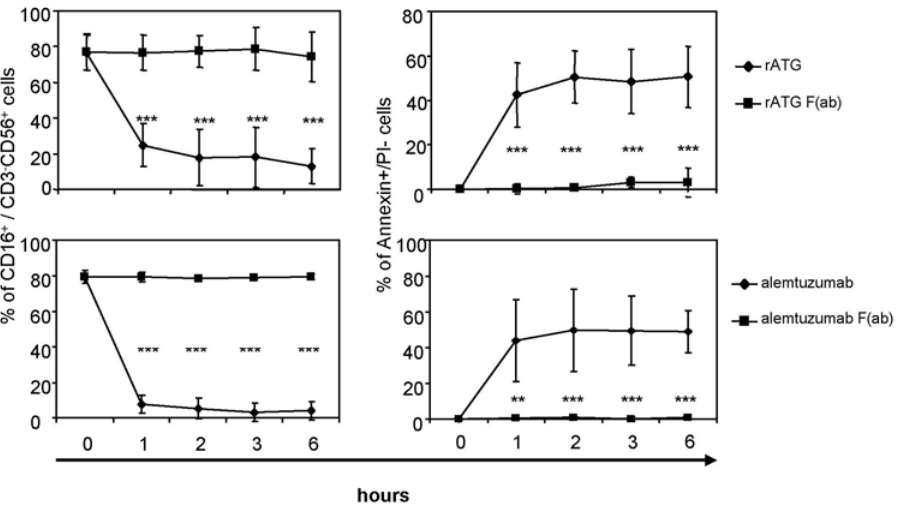
Figure 8. Application of F(ab) rATG and alemtuzumab fragments abolishes apoptosis and targeting of CD16 on CD56 + CD16 + NK cells. NK cells were treated either with 1 m g/ml rATG or alemtuzumab or with 1 m g/ml F(ab) fragments of rATG or alemtuzumab for 1, 2, 3 and 6 hours. Controls remained untreated. Values of CD56 + CD16 + NK cells are displayed as means 6 SD (n=5); asterisks (*) indicate significant values compared to controls (***p , 0.001, left panel). F(ab) fragments of rATG or alemtuzumab did not induce apoptosis and did not target CD16. Annexin V + /PI 2 CD56 + CD3 2 cells were normalized to untreated cells. Values are displayed as means 6 SD of five independent experiments. P values are related to the rATG/alemtuzumab treatment: ***p ,